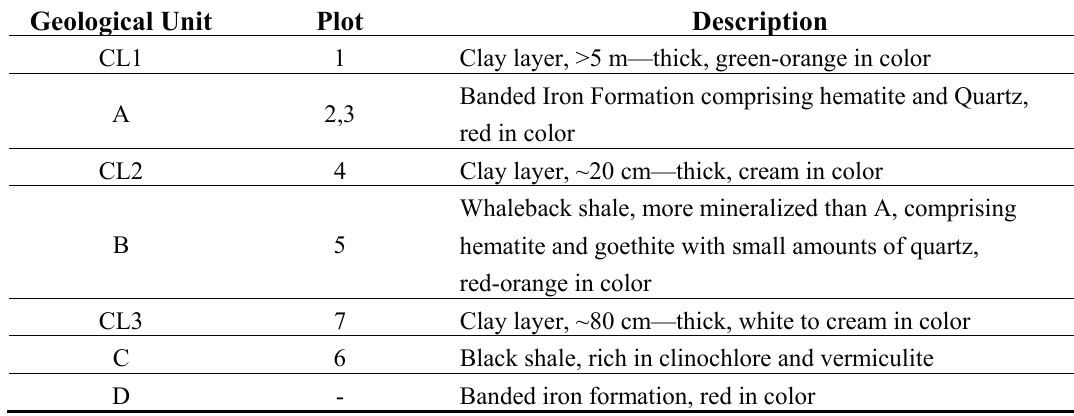
Table 1. Description of geological units and location of plots shown in Figure 1.